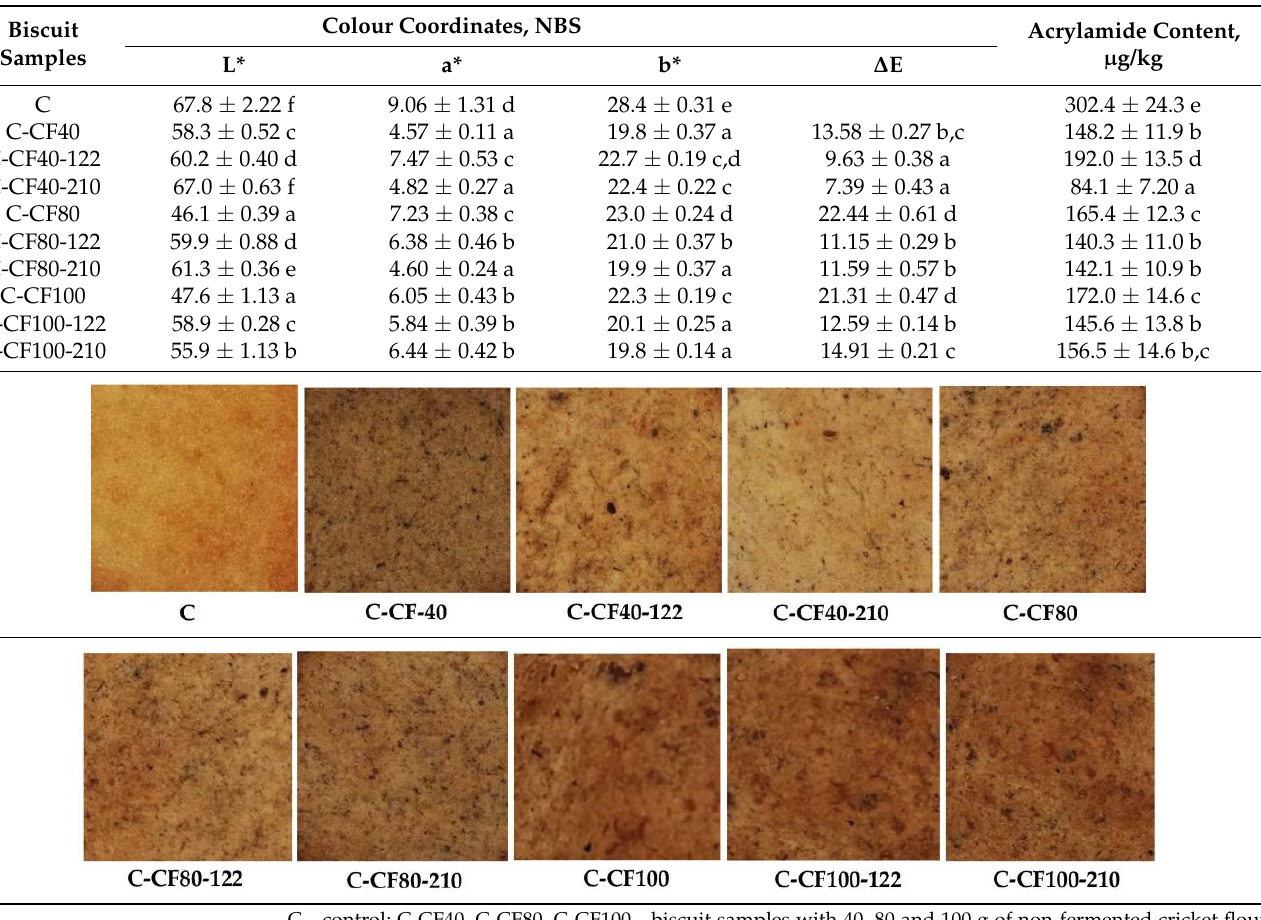
strain (on average 15.7% lower). Table 5. Colour coordinates (a*, b* and L*), total colour difference (ΔE), acrylamide concentration in biscuit samples, and images of biscuit samples.